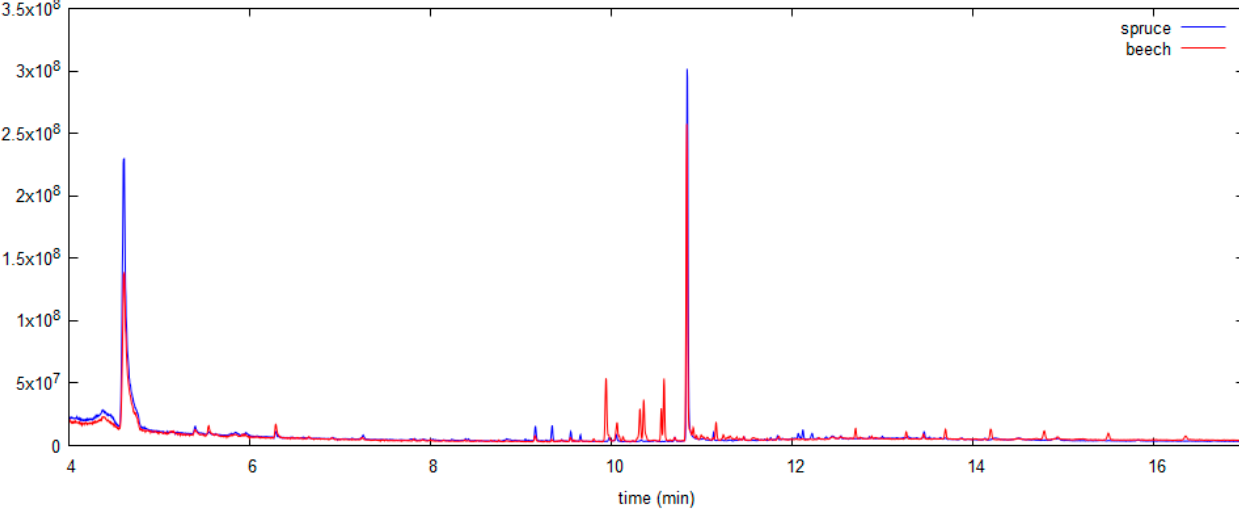
Figure 2. GC–MS TIC chromatograms of acetone extracts from beech and spruce model wood samples (PCP at 10.8 min).